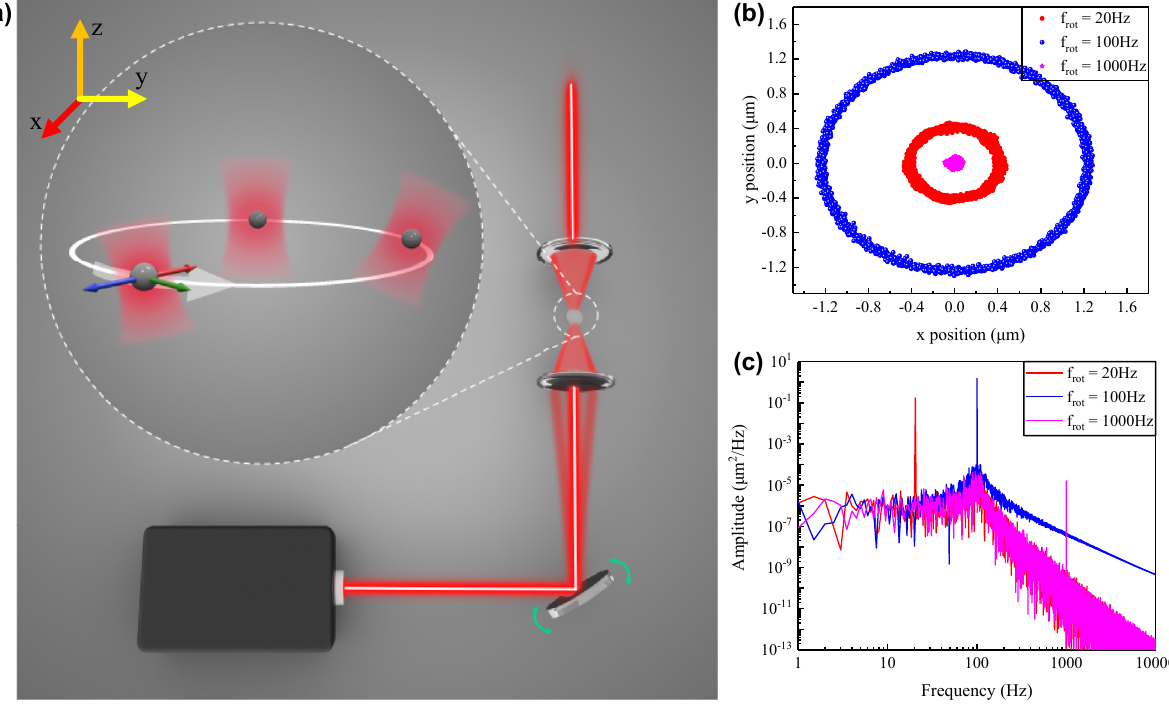
Figure 2: Illustration of an orbiting levitated particle in a rotational optical trap and typical simulated trajectories and power spectrum densities (PSDs) of an orbital microsphere. (a) Schematic of an orbiting levitated particle in a rotational optical trap caused by periodically tilting the incident optical beam. (b) Scatter plots of the orbital particle position distribution under various rotational frequencies. (c), PSD of the x -coordinates of levitated particle, corresponding to the simulation in